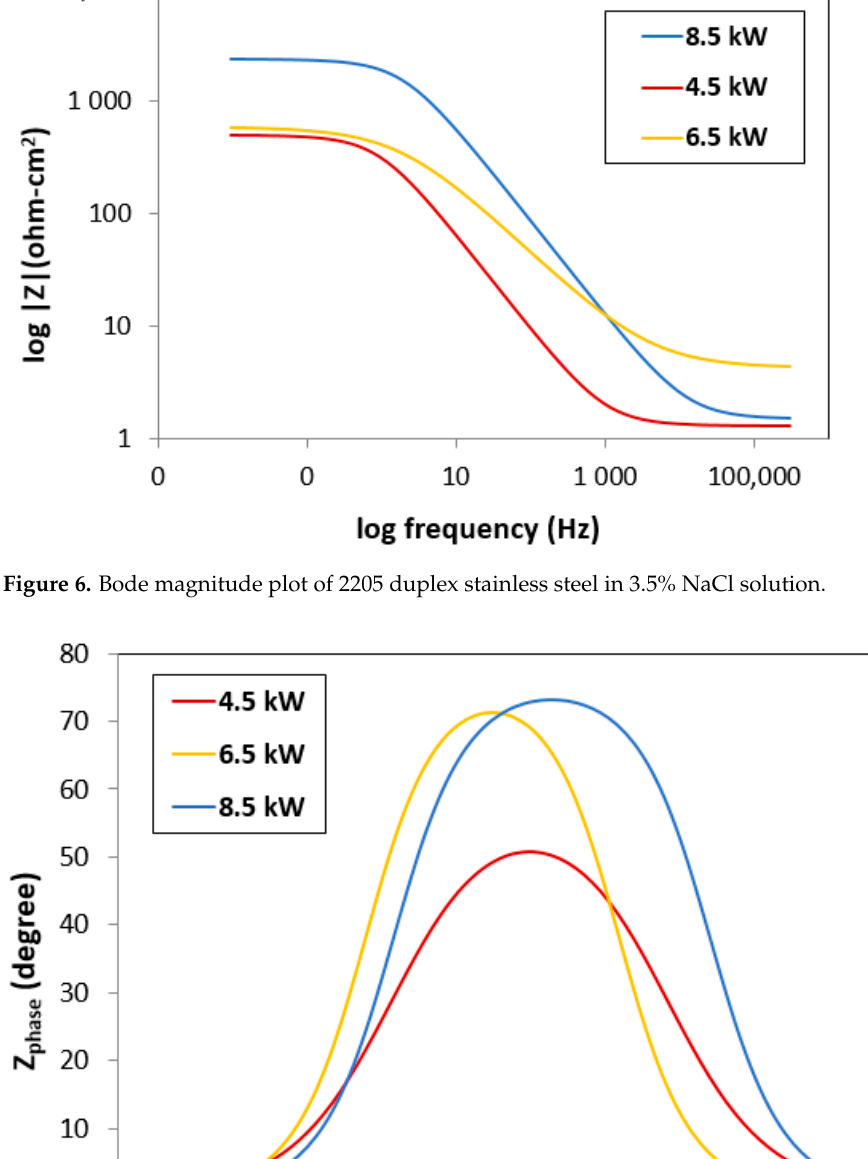
Figure 5. Nyquist plot of 2205 duplex stainless steel in 3.5% NaCl solution.